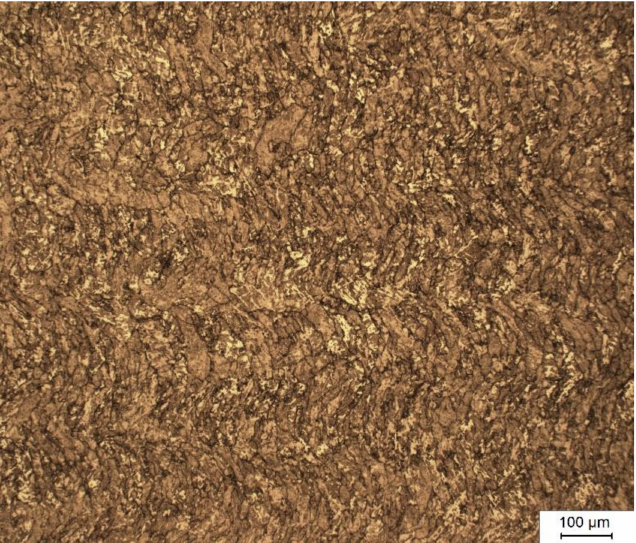
Figure 3. Optical micrograph of metallographic cross-section of PBF-EB processed X65MoCrWV3-2. Build direction is vertical. The main processing parameters were beam power 600 W, scan speed 3500 mm/s, and hatch distance 50 µ m.